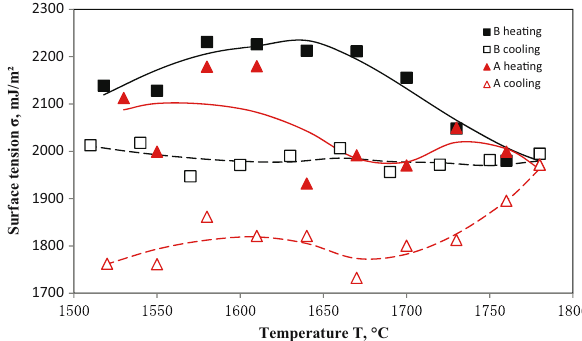
Figure 5: Changes in the surface tension of samples A and B as a function of